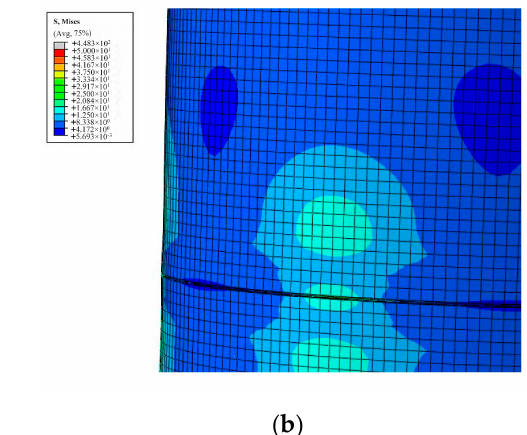
( b ) Figure 13. Acceleration response SFFT (Under constant-amplitude excitation); ( a ) No loosening; ( b ) One bolt loosened to 0.3 kN. Considering that the amplitude of the impulse load often produces a certain amount of change in the actual working conditions, the continuous impulse load with variable amplitude is also calculated (Response results in Figure 14). The amplitude variation in the constant impulse load varies in the form of a random function: 𝐹 (cid:3028)(cid:3040)(cid:3043) = 1000 (cid:3400) (1 − 𝑟𝑎𝑛𝑑(0,0.1)) (12) Figure 14. Acceleration response of random variable amplitude continuous impulse excitation.